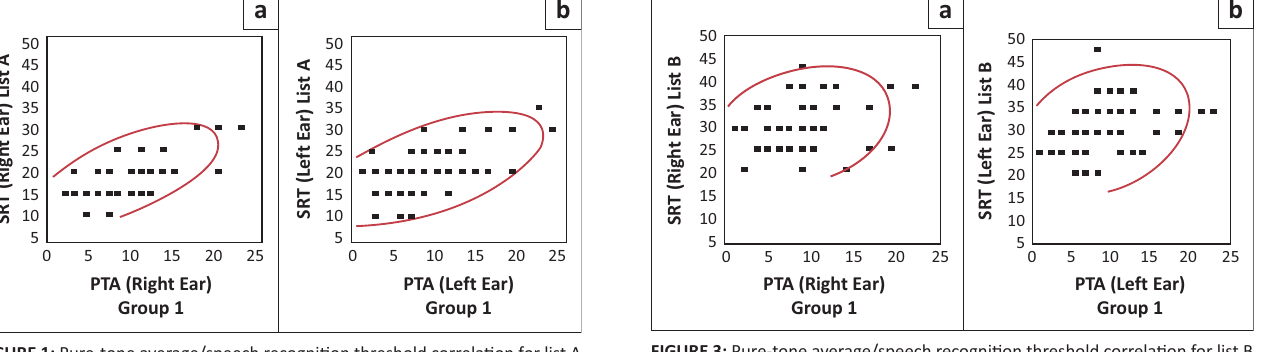
FIGURE 1: Pure-tone average/speech recognition threshold correlation for list A in group one ( N = 54R; 51)